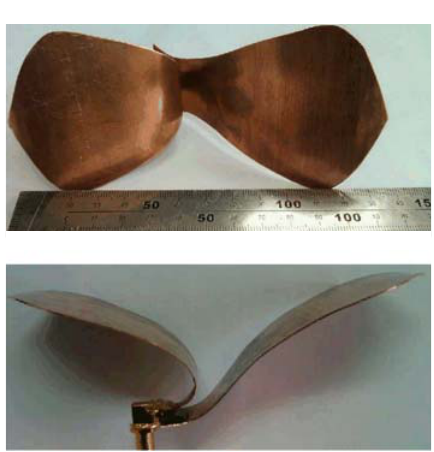
Figure 2: Photograph of the manufactured